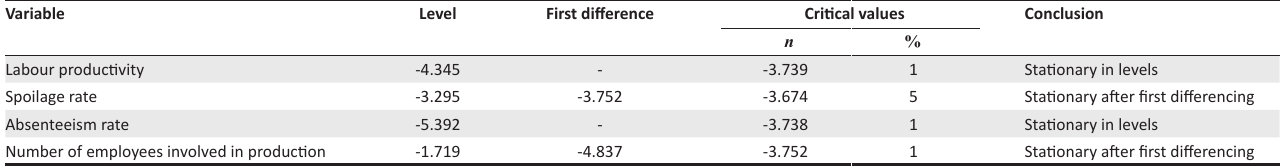
TABLE 1: Augmented Dickey Fuller stationarity test results.